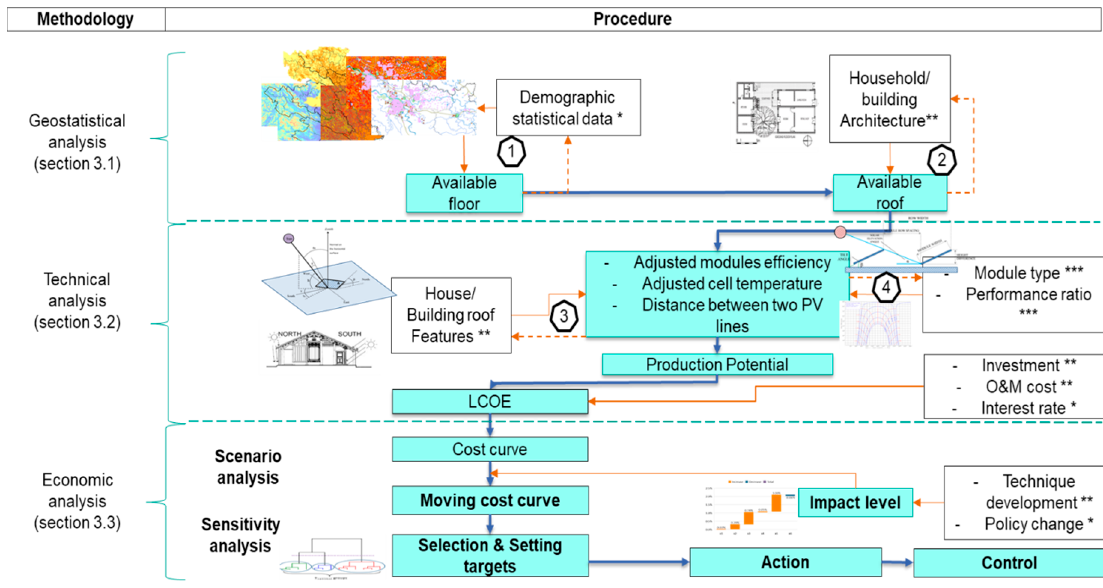
Figure 1. Methodology flow chart of the proposed potential assessment model for rooftop PV. Pictures are own illustrations, based on sources for Figures 2–5 and reference [32].